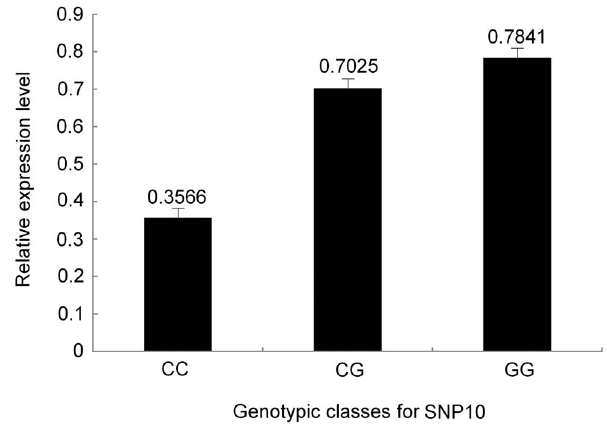
Figure 6. Expression levels of three genotypic classes for SNP10. The error bars represent + SD.